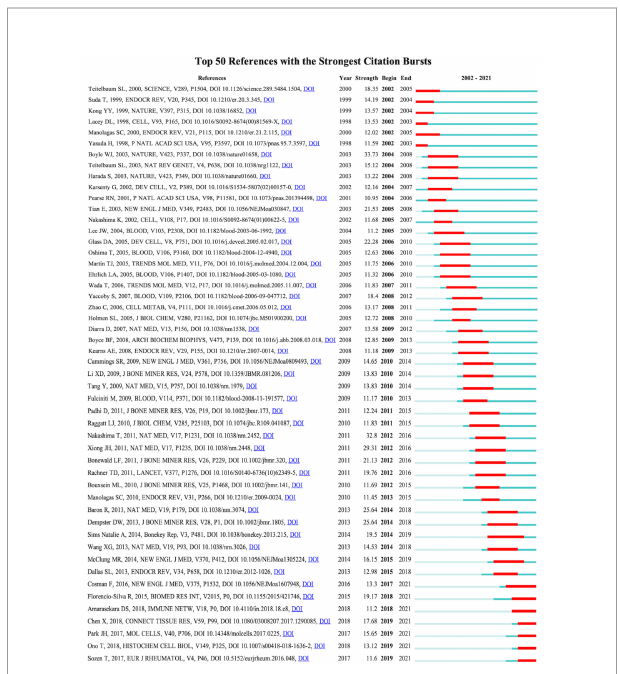
FIGURE 9 | Top 50 references with the strongest citation bursts (sorted by the beginning year of burst). Notes: The blue bars mean the reference has been published; the red bars mean citation bursts.